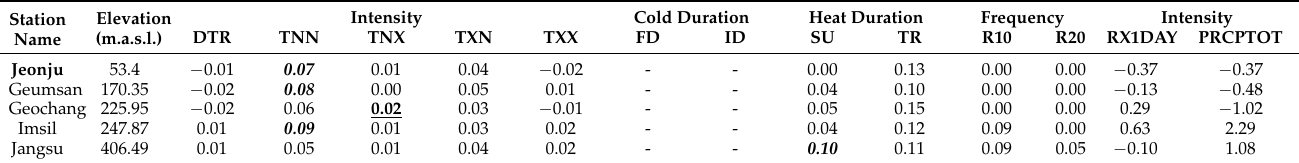
Table A13. Trend magnitudes for the month of July in the UGRB for 33 years